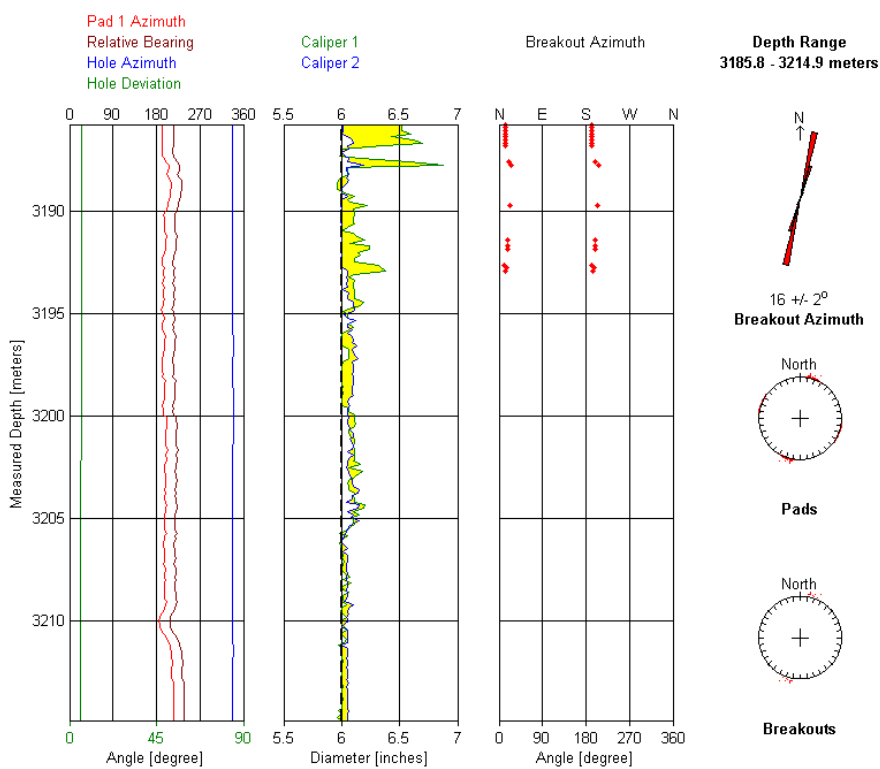
Figure 12. Caliper analysis for W203.